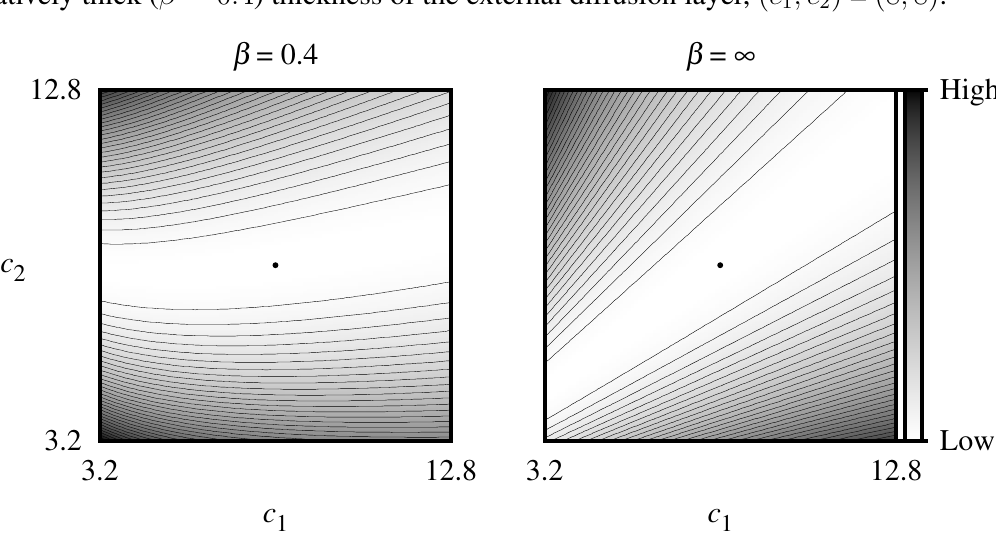
Figure 4. Contour lines of the objective function given by Equation (17) for the noise-free biosensor responses simulated at V a relatively thick ( β = 0 . 4 ) thickness of the external diffusion layer, ( c